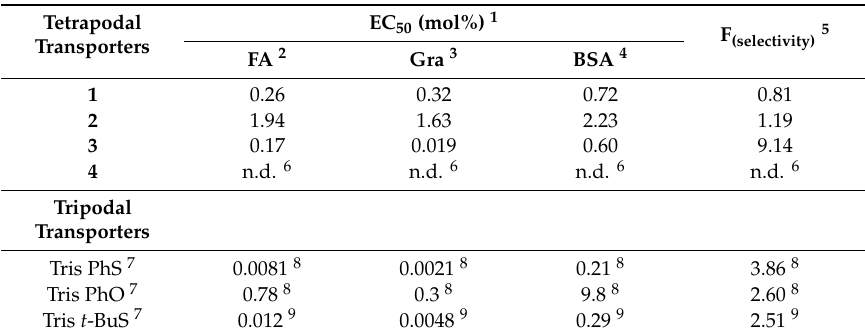
Table 3. The EC 50 and enhancement factors (F) of the tetrapodal transporters were calculated from experimental data collected from the HPTS NMDG-Cl transport selectivity assay and comparison tripodal transport